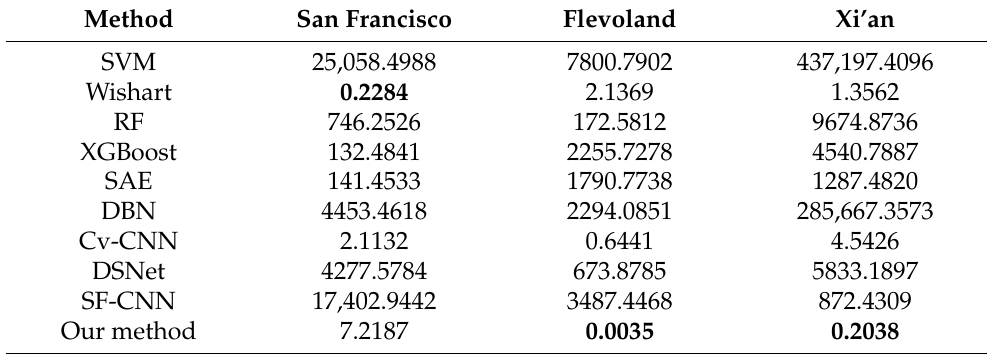
Table 6. Chi-Square values of different methods’ results, where the minimum value for every class is are marked in